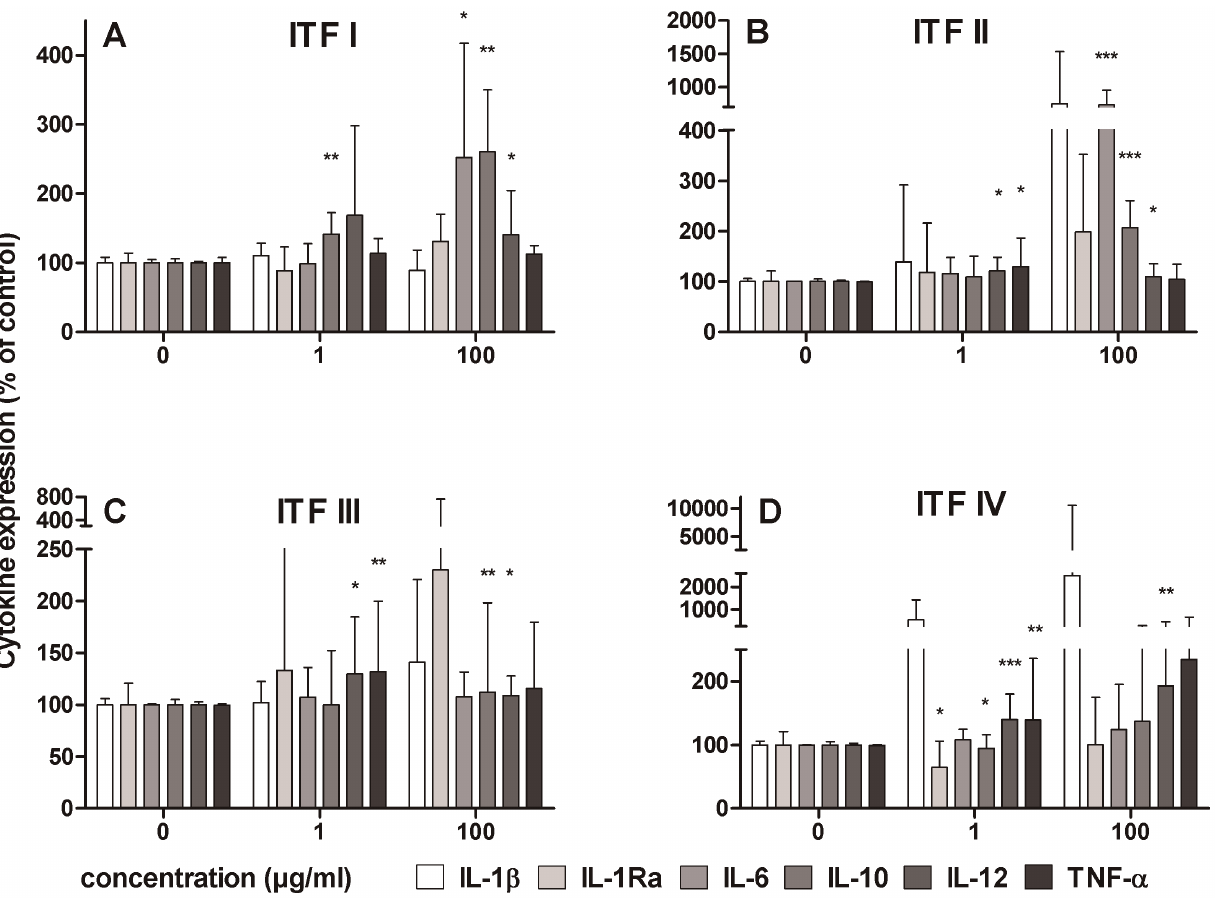
Figure 3. Induction of cytokines by b 2 R 1-fructan formulations with different chain length (DP range), at 0, 1, and 100 m g/ml. Statistical significance levels were determined with a non-parametric Mann-Whitney U-test for unpaired observations (two-tailed). Mean and SD of cytokine expression are plotted as percentage of controls (represented by 0 m g/ml), which were set to 100% (n=6). Panel A to D represent cytokine expression induced by ITF I to IV respectively.